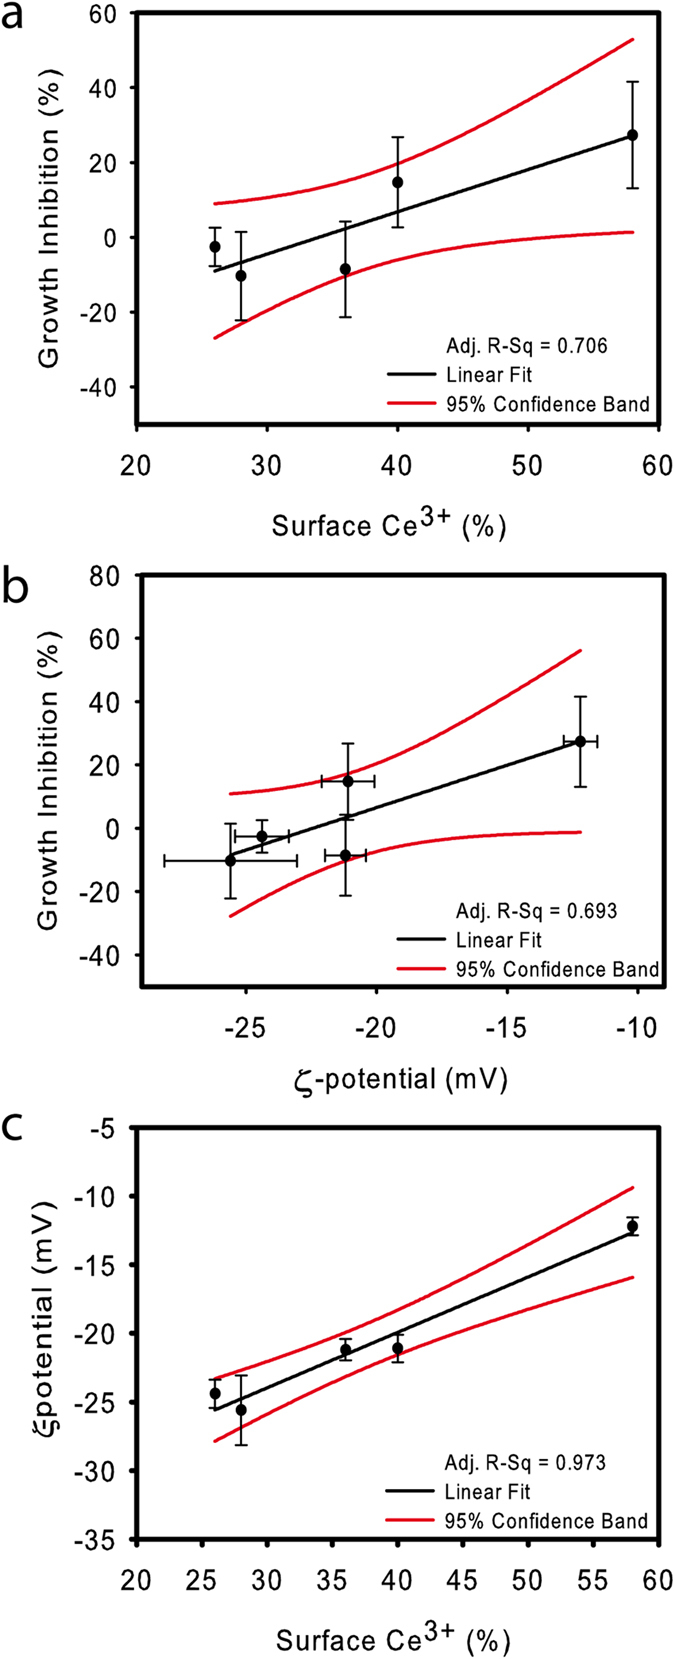
Correlation analyses.(a) Correlation between algal growth inhibition (%) caused by CNPs exposure and % surface Ce3+ of each tested CNP. (b) Correlation between algal growth inhibition (%) and ζ-potential (mV) in OECD-medium. (c) correlation between ζ-potential (mV) in OECD-medium and % surface Ce3+ of each tested CNP.